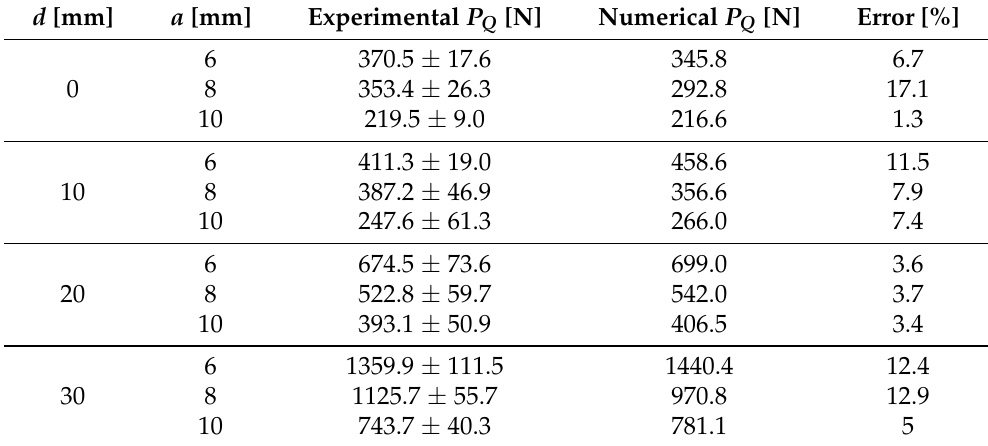
Table 4. Comparison of the peak loads obtained from experimental and numerical analysis.